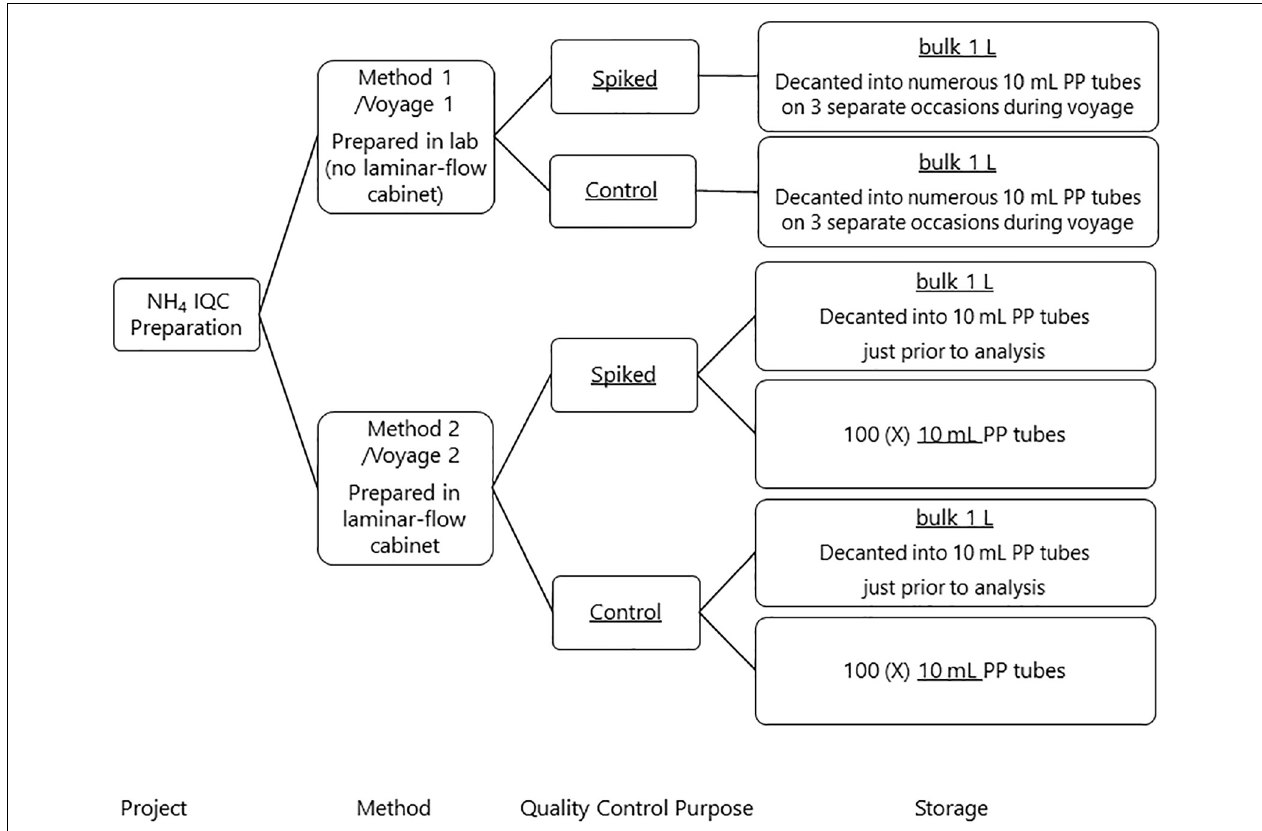
FIGURE 2 | Ship track (gray line) and CTD station (crosses) on the in2018_v01 (voyage 1) GO-SHIP SR03 transect, S04 and P11S lines. Stations 31 and 56 are highlighted with the gray